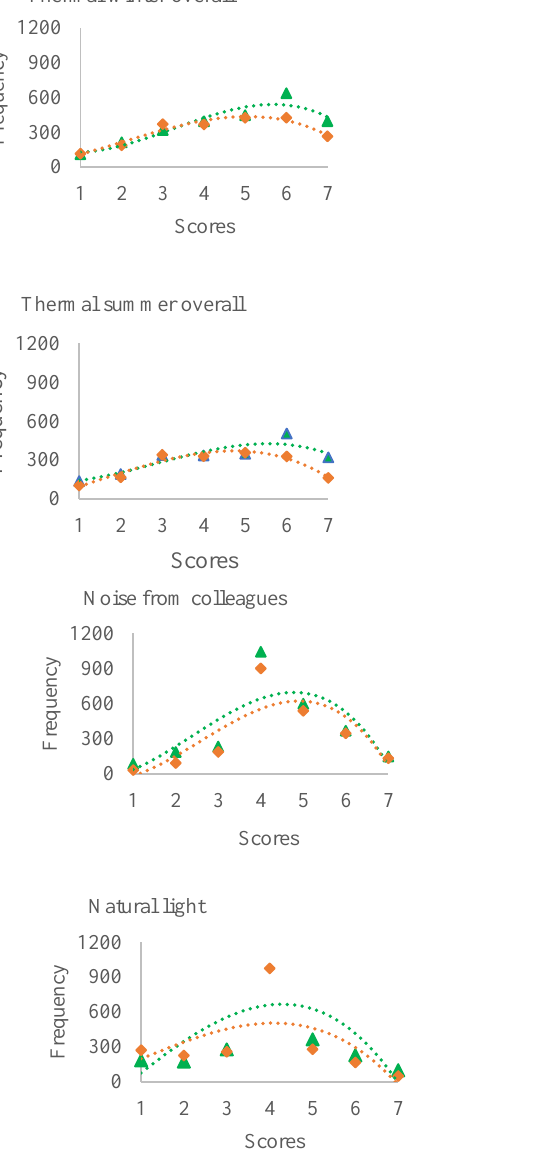
Figure 2. Distribution characteristics of median scores for environmental parameters.